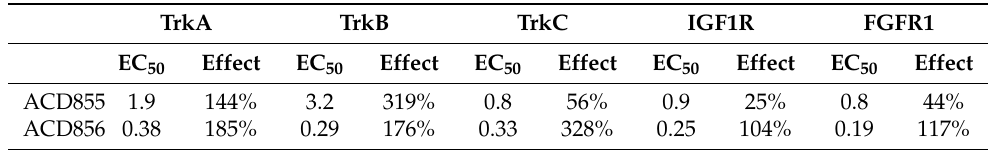
Table 1. Summary of EC 50 values ( µ M) and the efficacy (%) of ACD855 or ACD856 on the activation of neurotrophin (TrkA, TrkB or TrkC), insulin-like growth factor 1 receptor (IGF1R), and fibroblast growth factor receptor